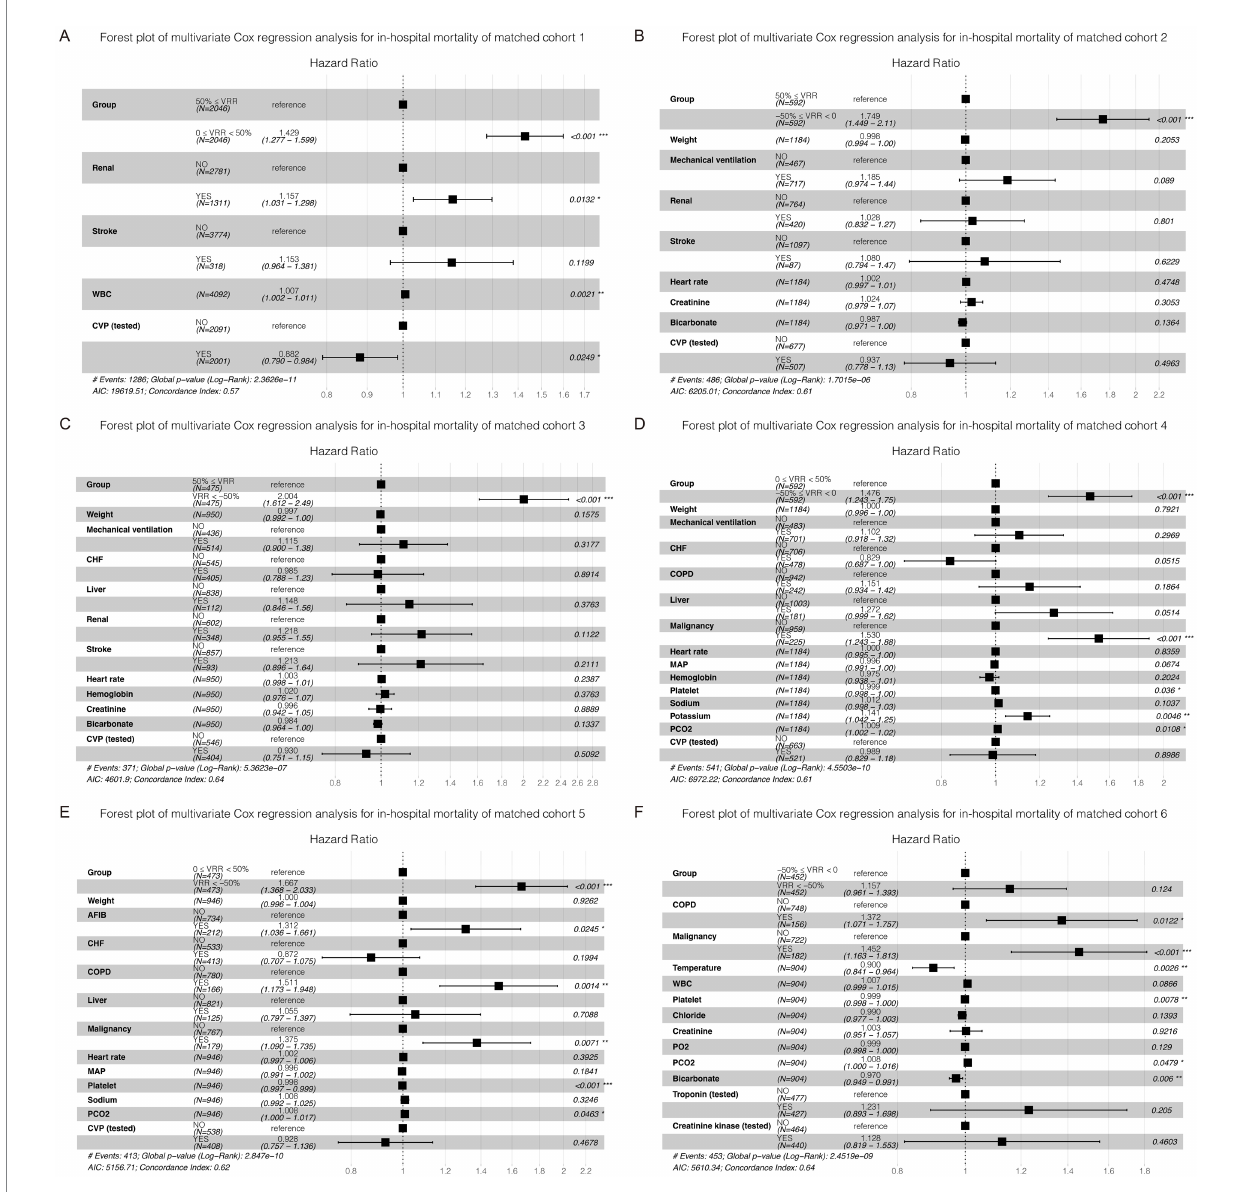
FIGURE 5 Forest plot of multivariate Cox regression analysis for in-hospital mortality in each cohort after pairwise PSM. Except for matched cohort 6 ( F , VRR < − 50% versus − 50% ≤ VRR < 0), there were statistically significant differences between any other groups (A–E)